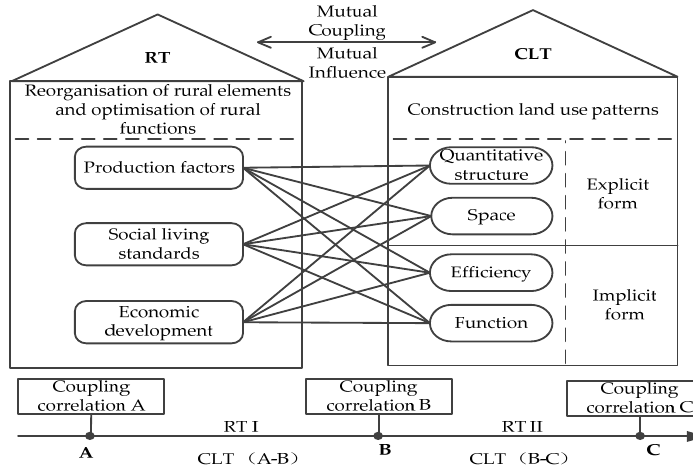
Figure 1. Theoretical framework of RT and CLT.